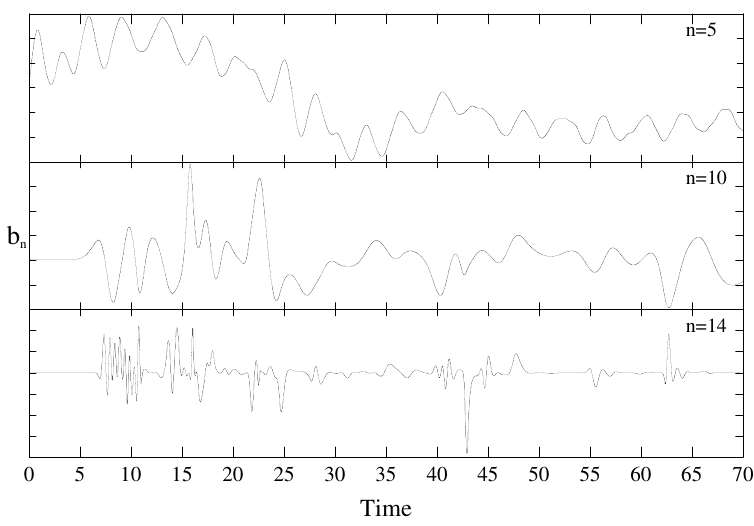
Figure 90: Time behavior of the real part of magnetic variable 𝑏 𝑛 ( 𝑡 ) at three different shells 𝑛 , as indicated in the different